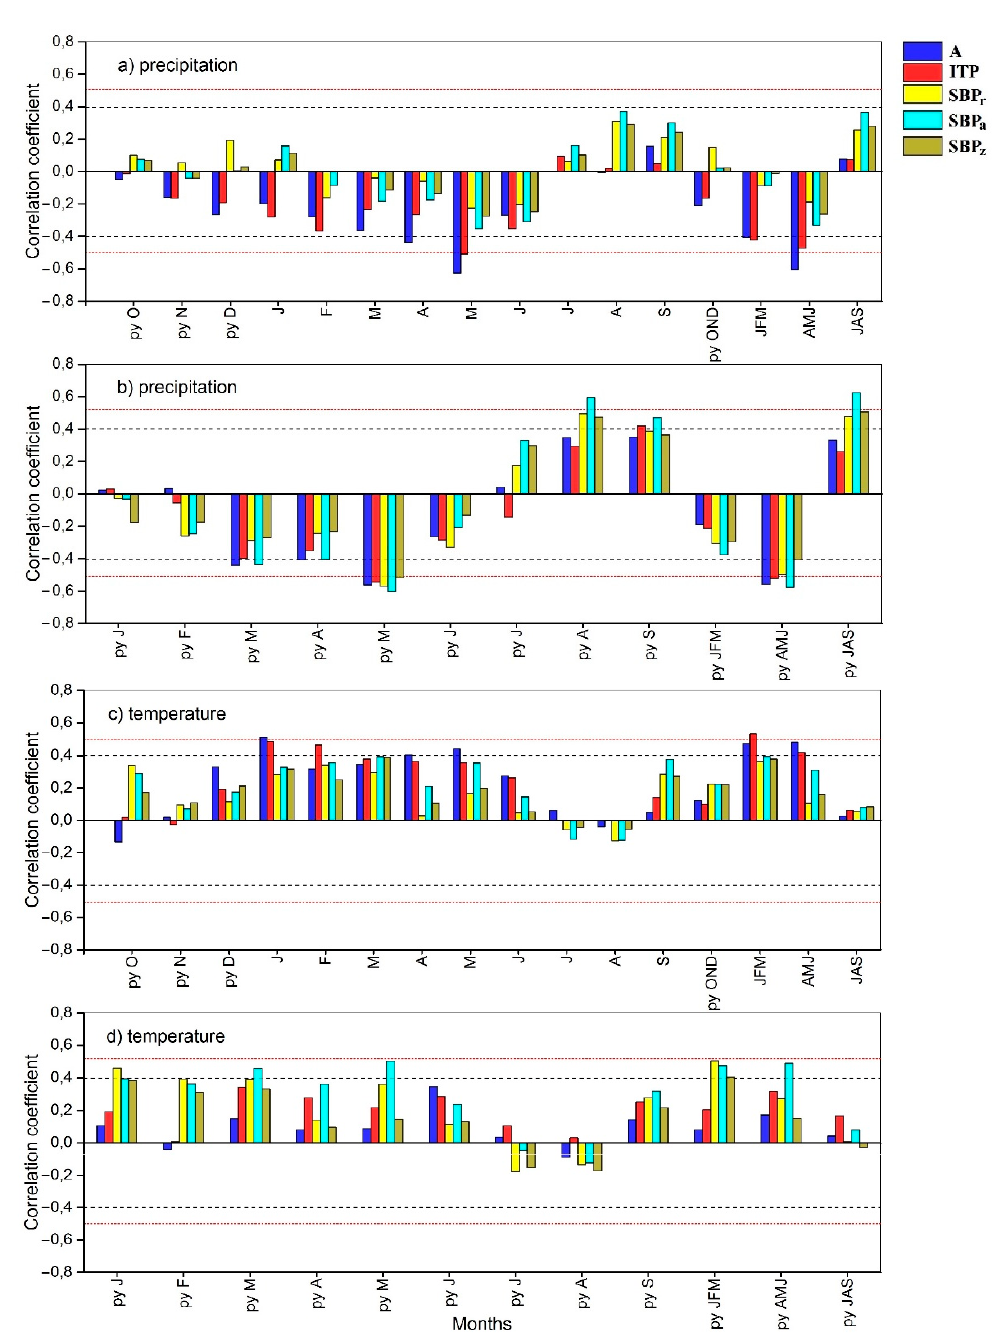
Figure 7. Correlations between A, ITP, SBP r , SBP a , and SBP z δ 18 O chronologies and precipitation ( a , b ) and temperature ( c , d ) for a 12-month period from October of the previous growing season (py O) until September of the growth year (S), seasonally averaged data (previous autumn: py OND, winter: JFM; spring: AMJ; summer JAS) ( a , c ), a 9-month period from January (py J) until September of the previous growing season (py S), and seasonally averaged data (winter: py JFM; spring: py AMJ; summer: py JAS) ( b , d ). Correlations were calculated for the period 1958–2007. Black and red horizontal lines indicate significant correlations at the p -value < 0.05 and p -value < 0.01 levels, respectively. Table 2. Significant climate- δ 18 O correlation of various chronologies during current year.